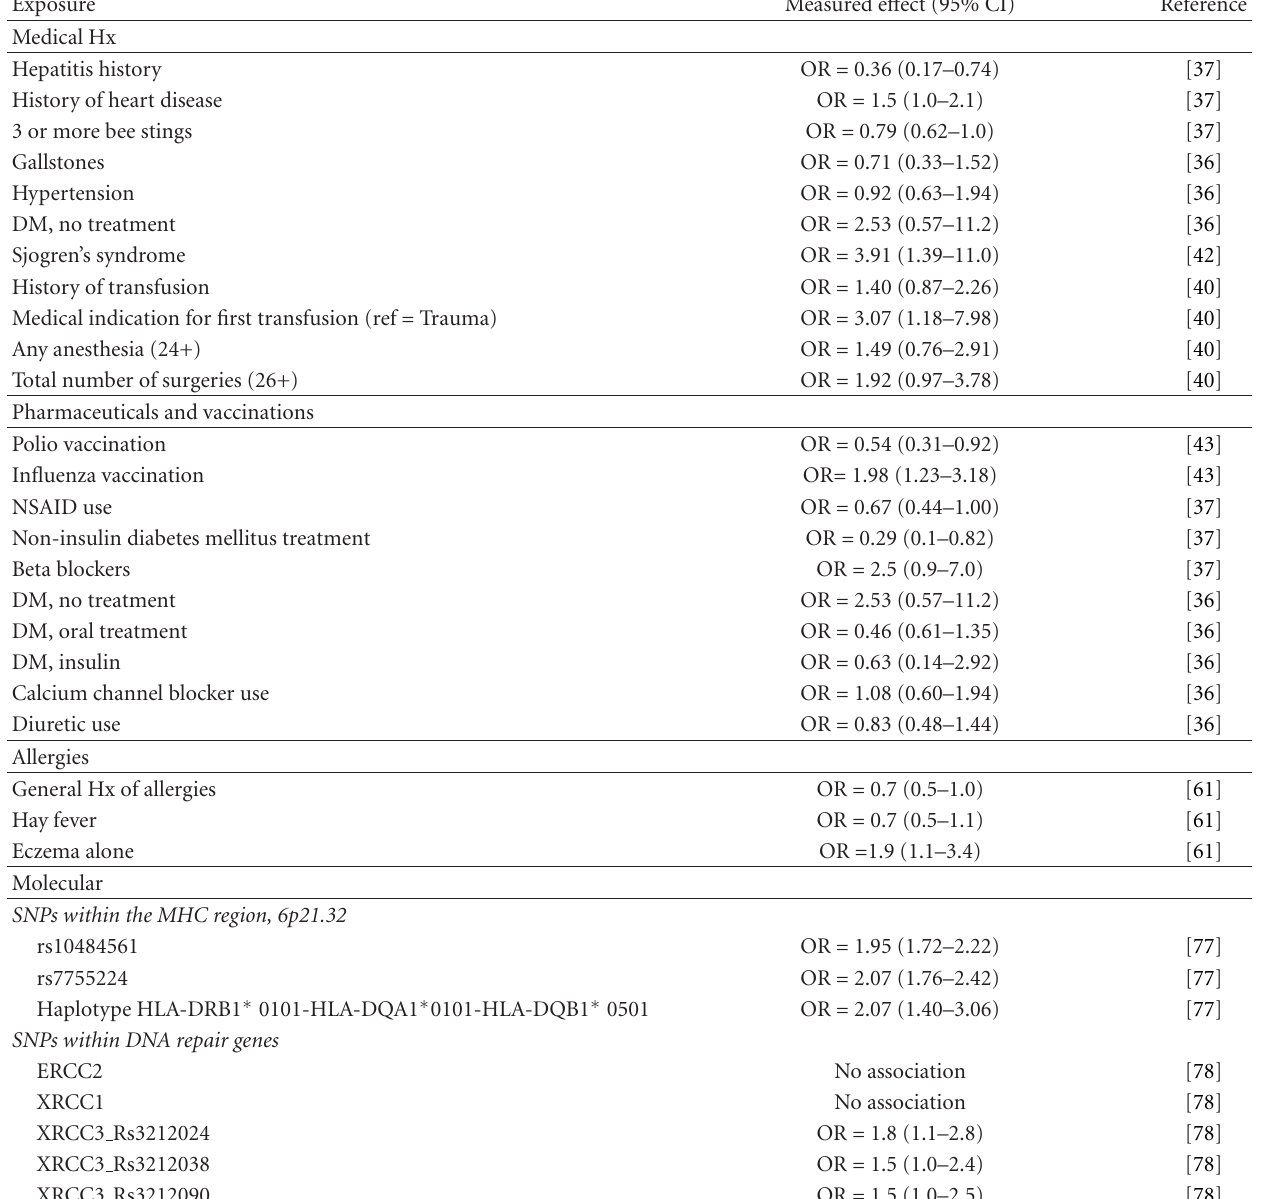
Table 2: Aspects of the medical history and genetic factors associated with